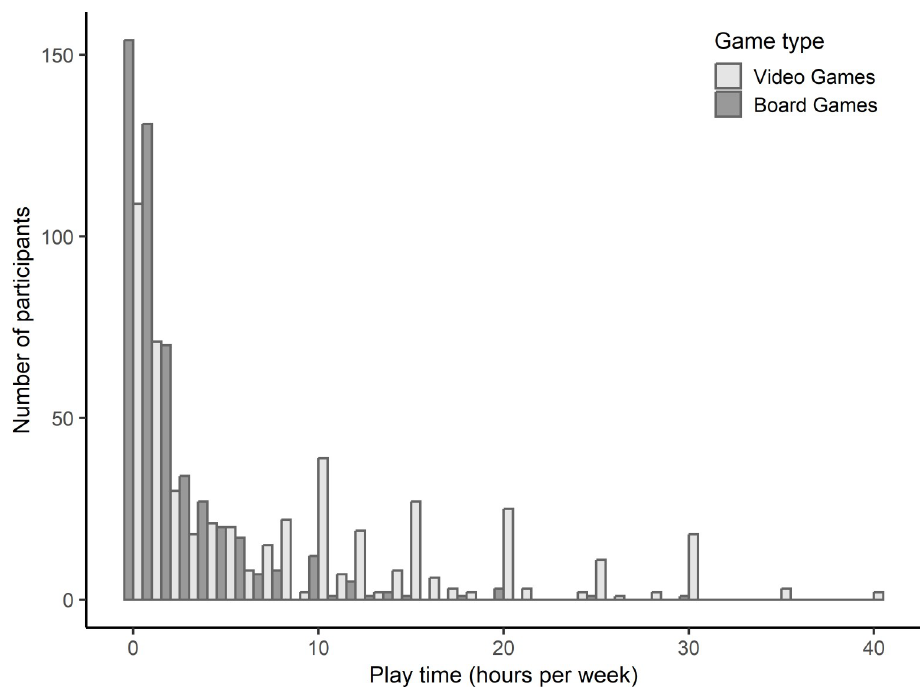
Fig 1. Distribution of hours playing video games and board games per week. Note. Each binwidth = 1 hour.